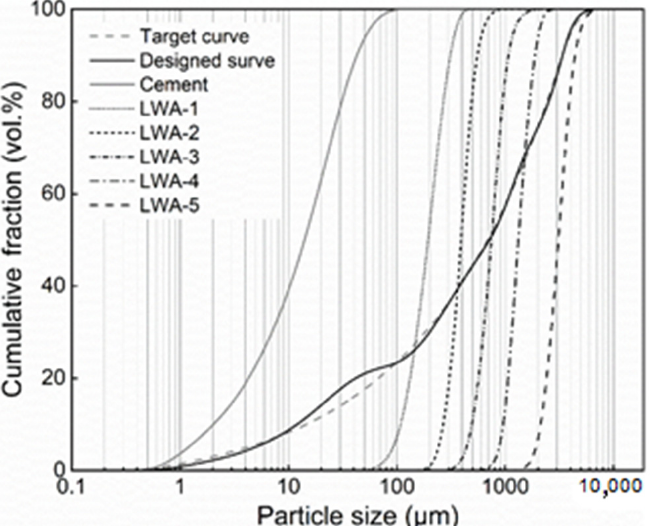
Figure 1. Particle size distributions of the cement and five light-weight aggregates (LWAs), and the resulting target curve and integral grading curve of the mixture.